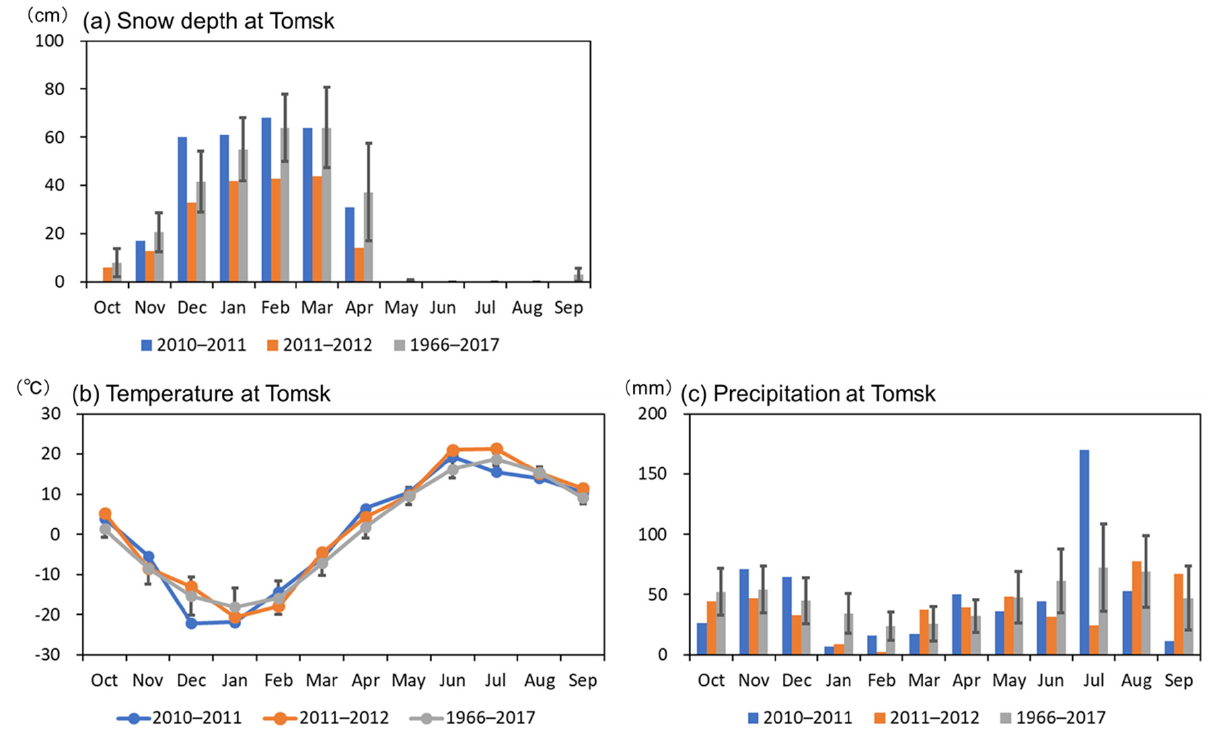
Figure 2. Seasonal change in hydrometeorological elements at Tomsk from October to September [10]. The bars indicate the standard deviation of the long-term mean for the respective gray legends. The data for 2010–2011 and 2011–2012 are also displayed. ( a ) Snow depth, ( b ) temperature, and ( c ) precipitation. The details of the hydrometeorological data are listed in Table 1.